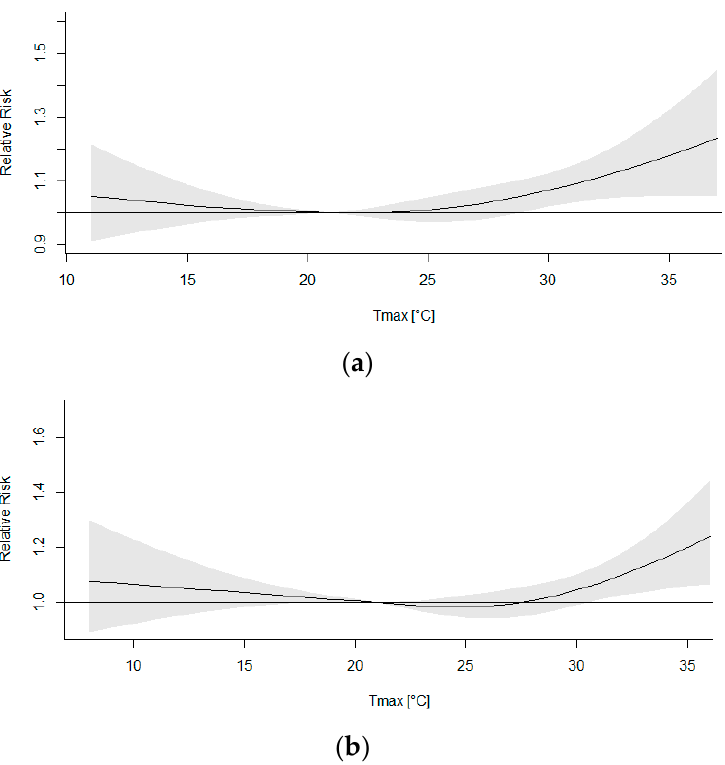
Figure 7. Relation between daily maximum temperature and relative mortality risk (all non-accidental causes) in warm months (June–September) for towns with a population of 10–25 thousand during 2001–2016: ( a ) Wielkopolska; ( b ) Ma ł opolska.